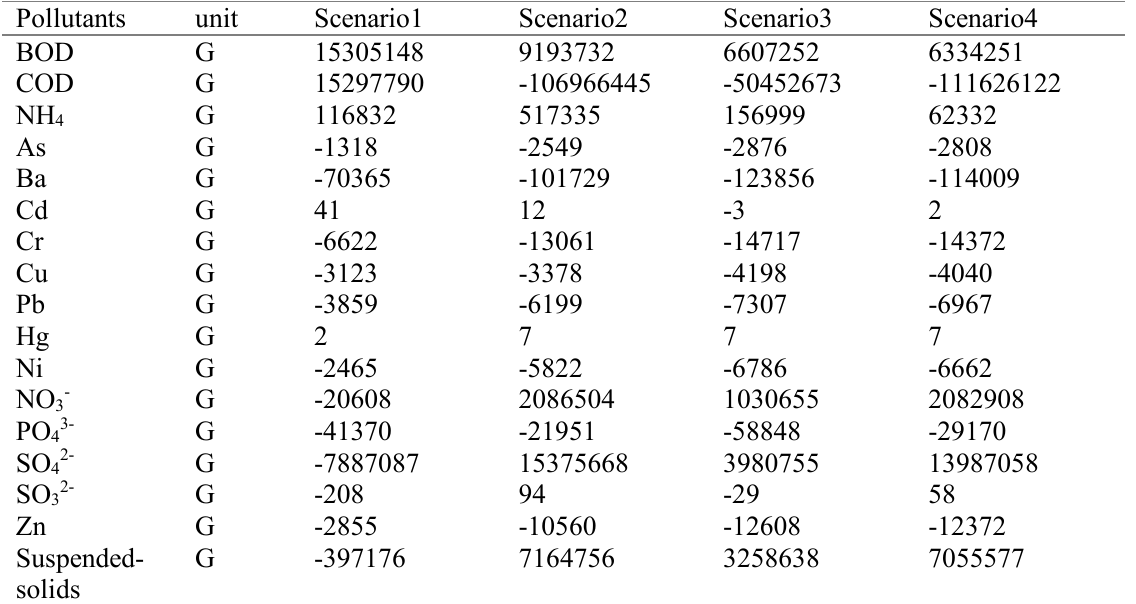
Table 5 . Water Emissions in different scenarios per functional unit (annual waste tonnage)